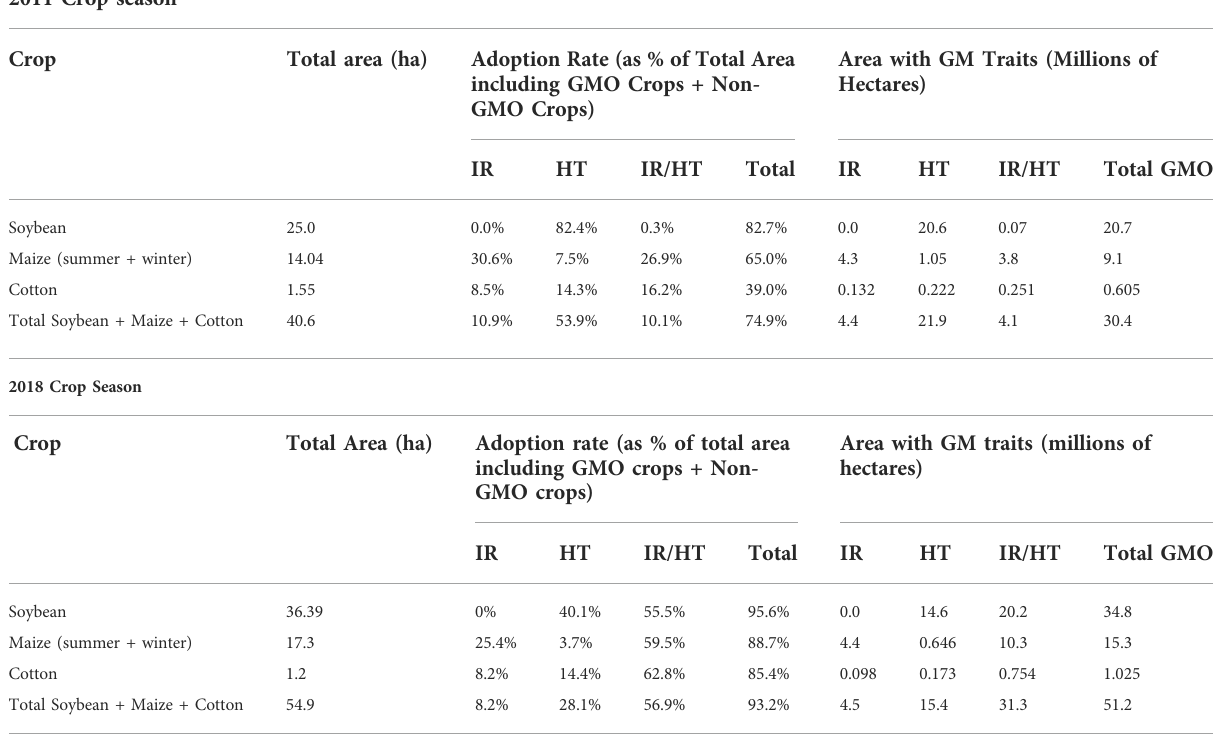
TABLE 4 Some insights of the Adoption of GM Seed in Brazil, 2011 and